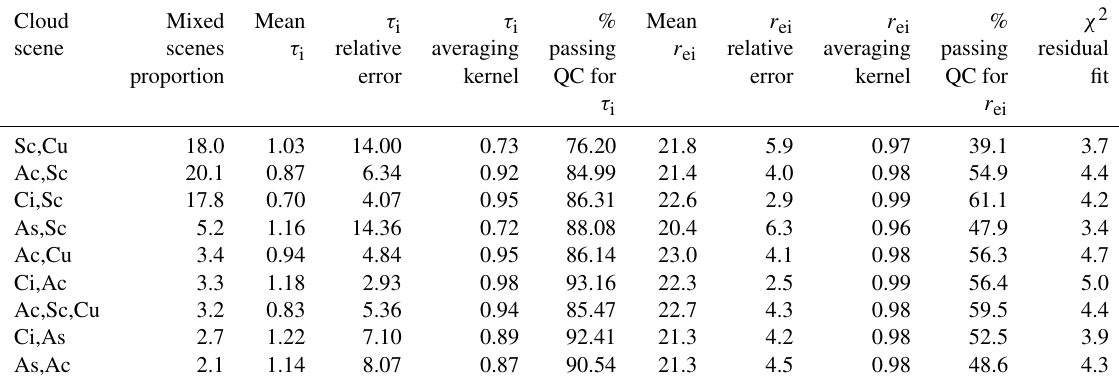
Table 6. Cloud ice properties for partly cloudy sky with multiple cloud types for the first nine most observed cloud scenes at the AIRS FOV scale. All else the same as Table